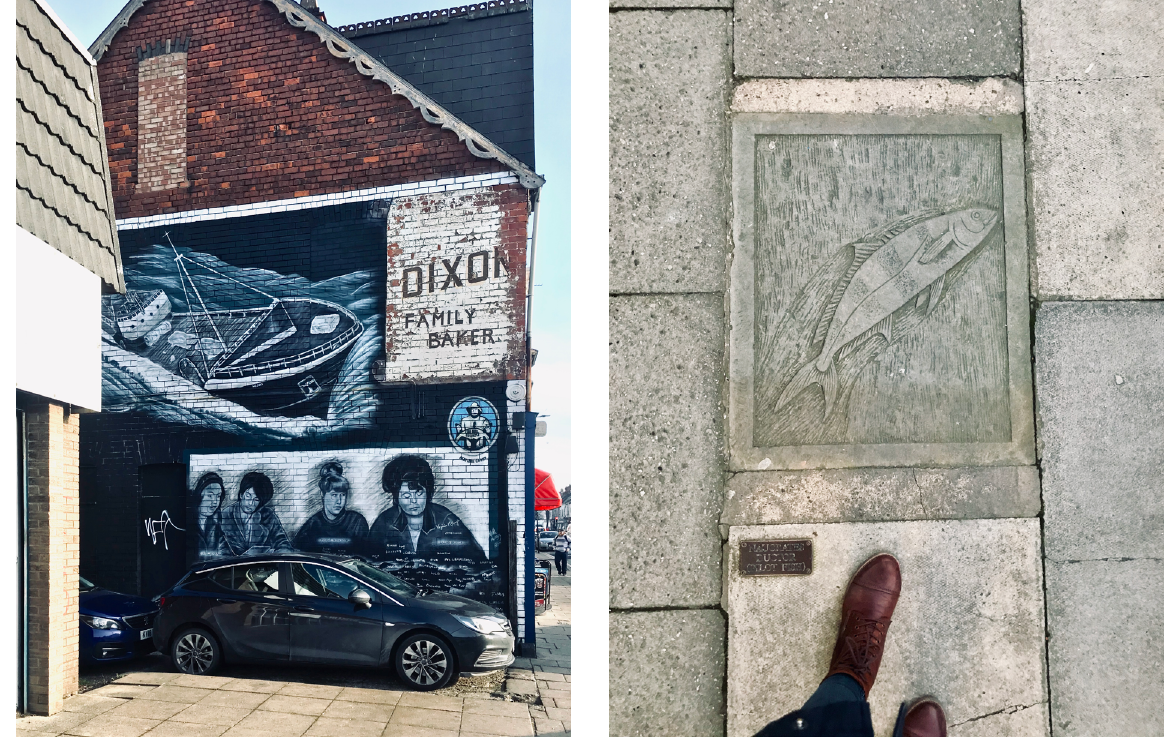
Fishing themed graffiti in Hessle road, home to the ex-fishing community and the Hull Fishing Heritage Center. The lower section depicts the ‘Headscarf wives’ who fought for safer working conditions on trawlers. Original photo by author, 2020. Sculpture part of Hull’s historic center fish trail, original photo by author,